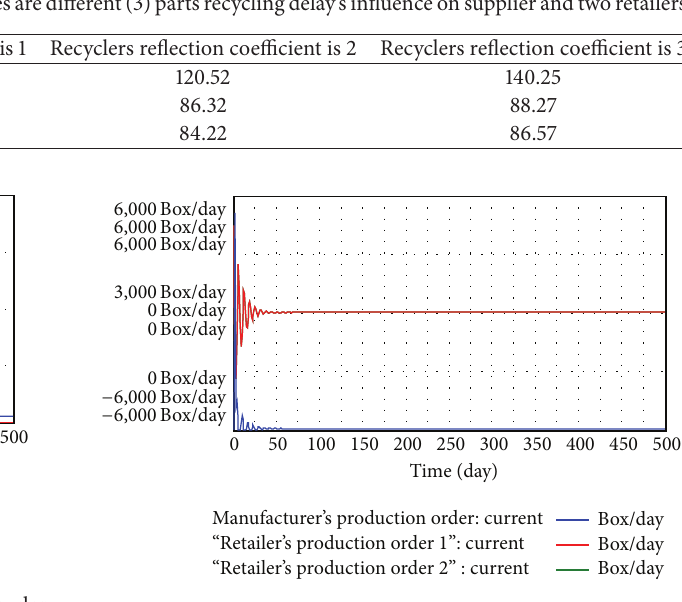
Table 3: The bullwhip effect when product recycling delay times are different (3) parts recycling delay’s influence on supplier and two retailers.